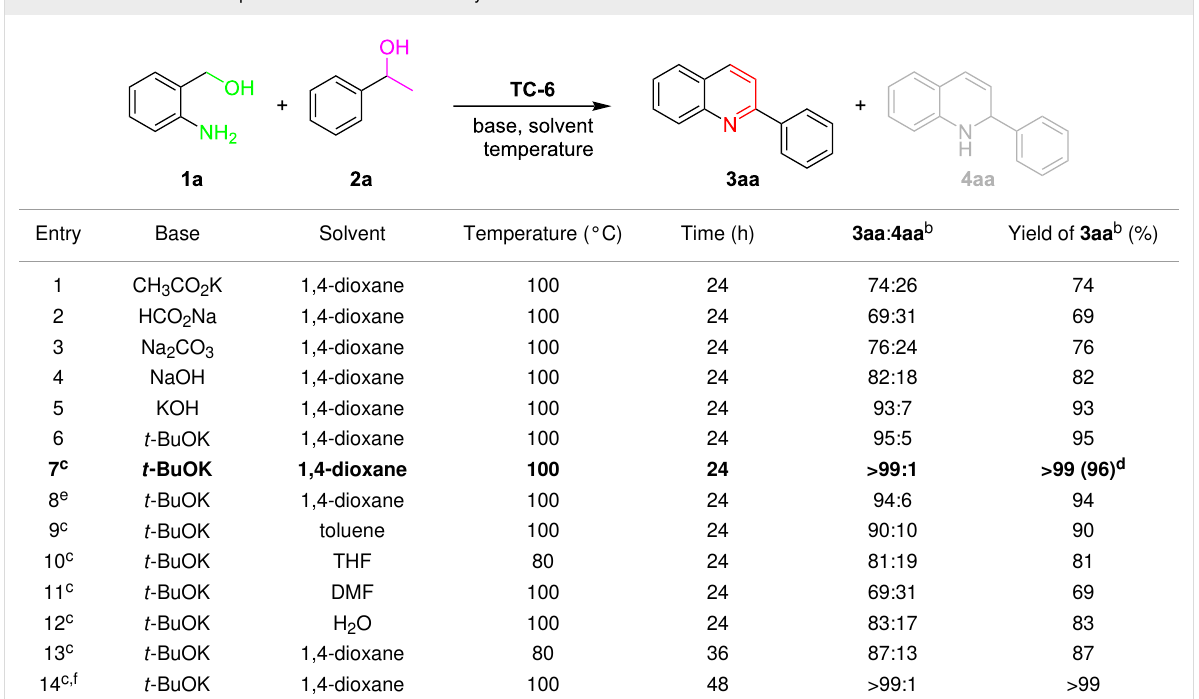
Table 2: Studies of reaction parameters in the iridium-catalyzed ADC reaction.